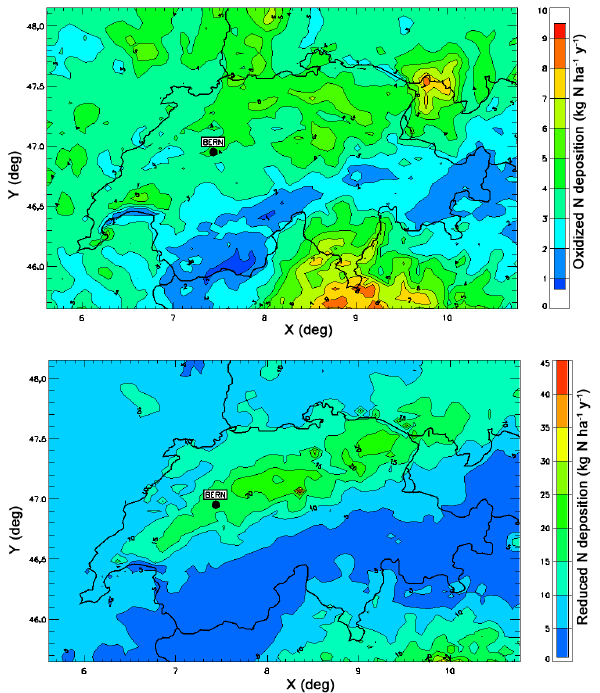
Figure 15. Deposition (kgNha − 1 yr − 1 ) of oxidized (upper panel) and reduced (lower panel) nitrogen compounds over the Swiss do- main (2006).